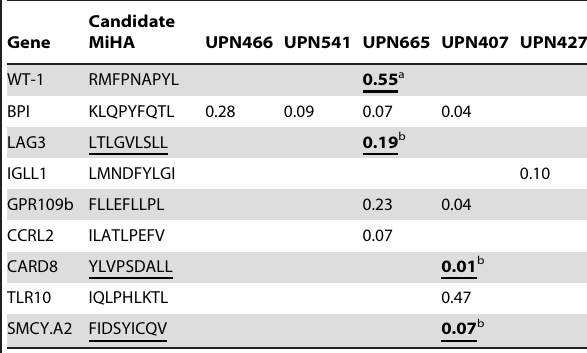
Table 3. Percentage of dual-color tetramer + CD8 + T cells in PBMC samples of transplanted patients screened after MHC- multimer based enrichment and short-term